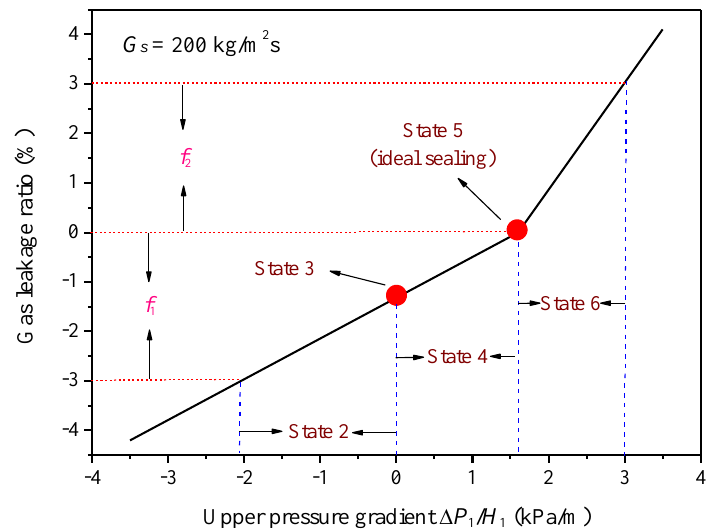
Figure 4. Variations of gas – solid flow state in the upper dipleg with the upper pressure gradient.